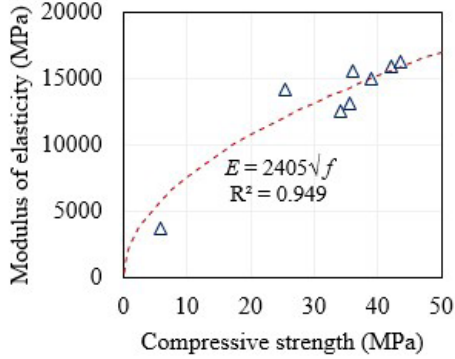
Figure 4. Relationship between 28-days compressive strength and modulus of elasticity of mortars with